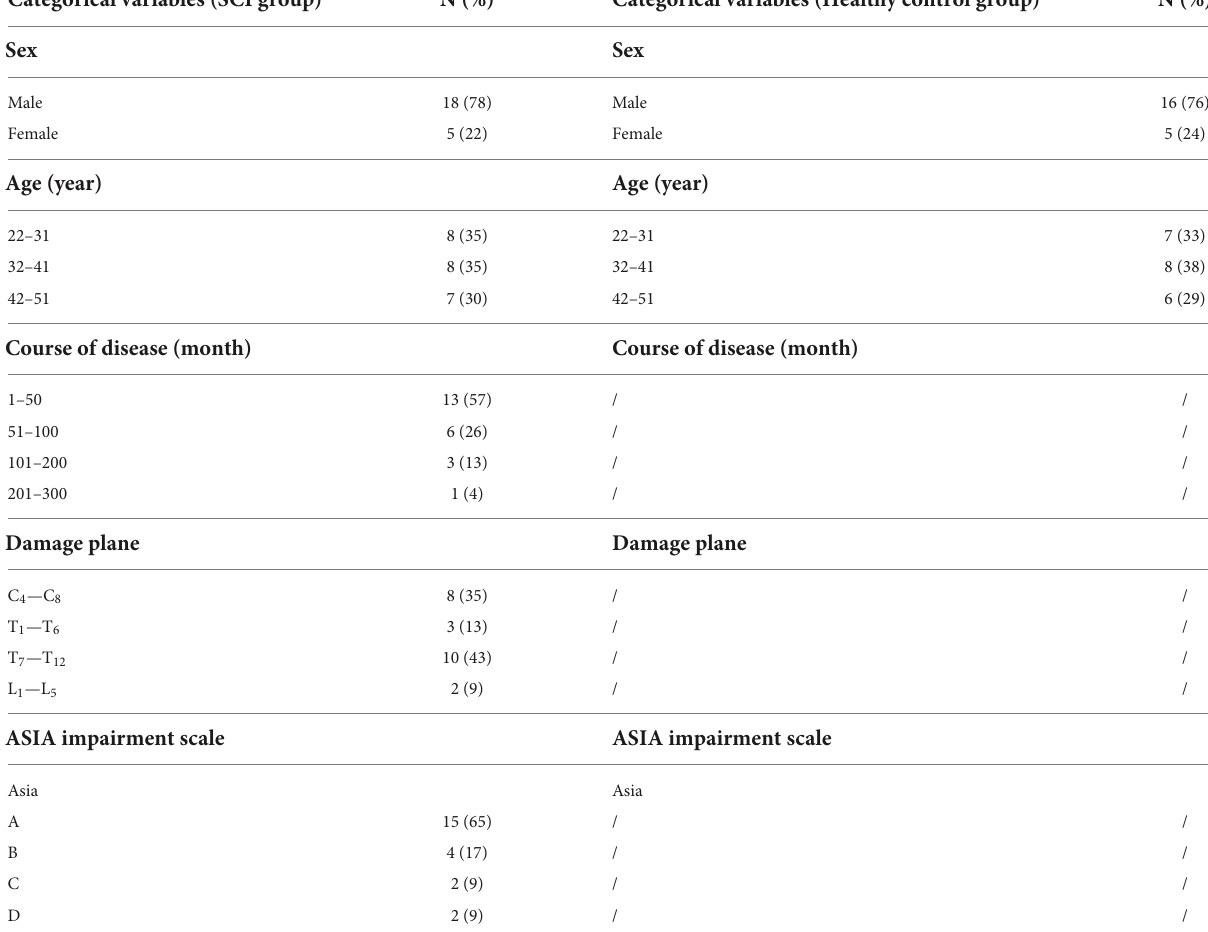
TABLE 1 Baseline characteristics of SCI patients ( n = 23) and healthy control ( n =